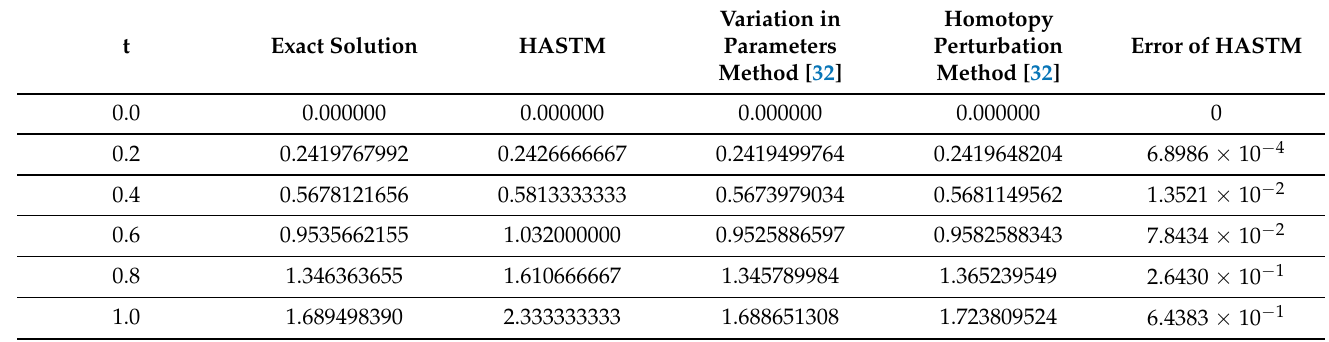
Table 1. Comparative analysis of the numerical results for u ( t ) at (cid:125) = − 1 and µ = 1 for Example